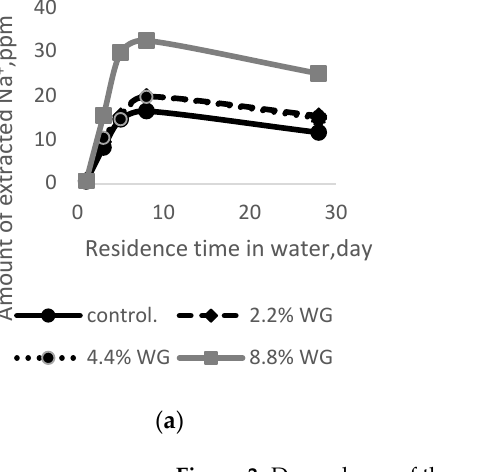
Figure 3. Dependence of the amount of extracted alkali cations on the addition of potassium WG and time in the water: ( a ) Na + ; ( b ) K + .